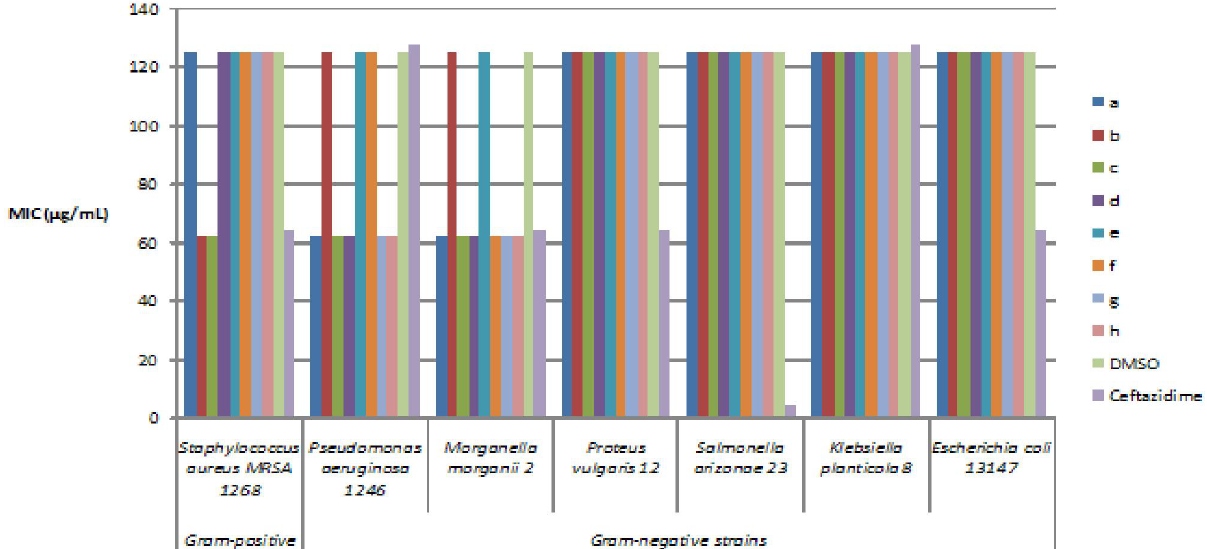
Figure 1. Minimum inhibitory concentration (MIC) of dibenz[ b , e